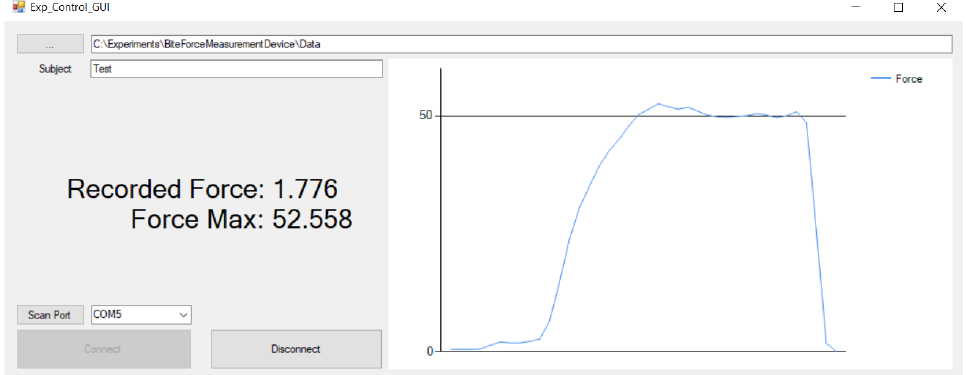
Figure 3. Data visualization software interface. C# based interface running on a PC allows visualizing and saving data sent wirelessly from the Arduino board. The software interface displays the instantaneous expressed force (Kg) and MBF achieved during the whole session.